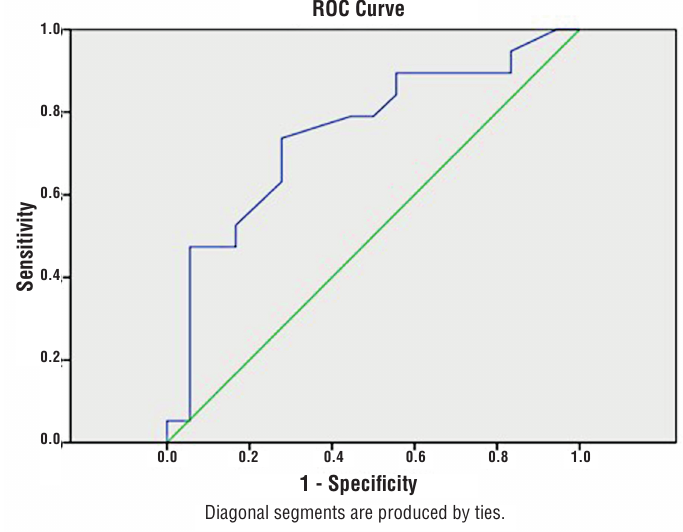
figure 2 - ROc curve analysis. Best correlation with 5.15 cm, sensitivity of 73% and specificity of 72%. AUc = 0.75 (p=0.01). ROc